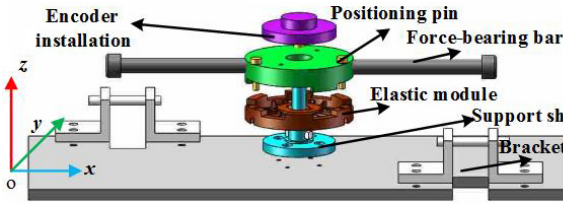
Figure 7. The calibration platform.